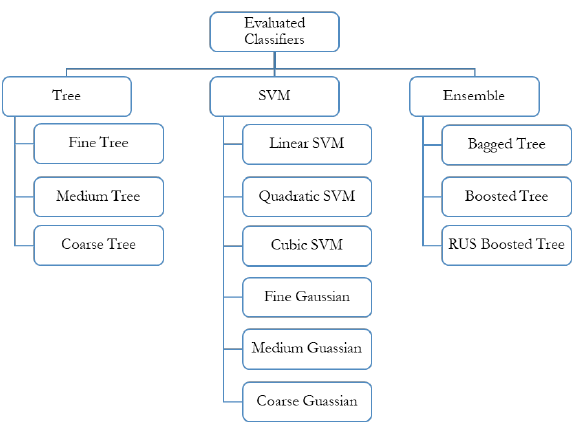
Figure 4. Algorithms used for classification by supervised learning.